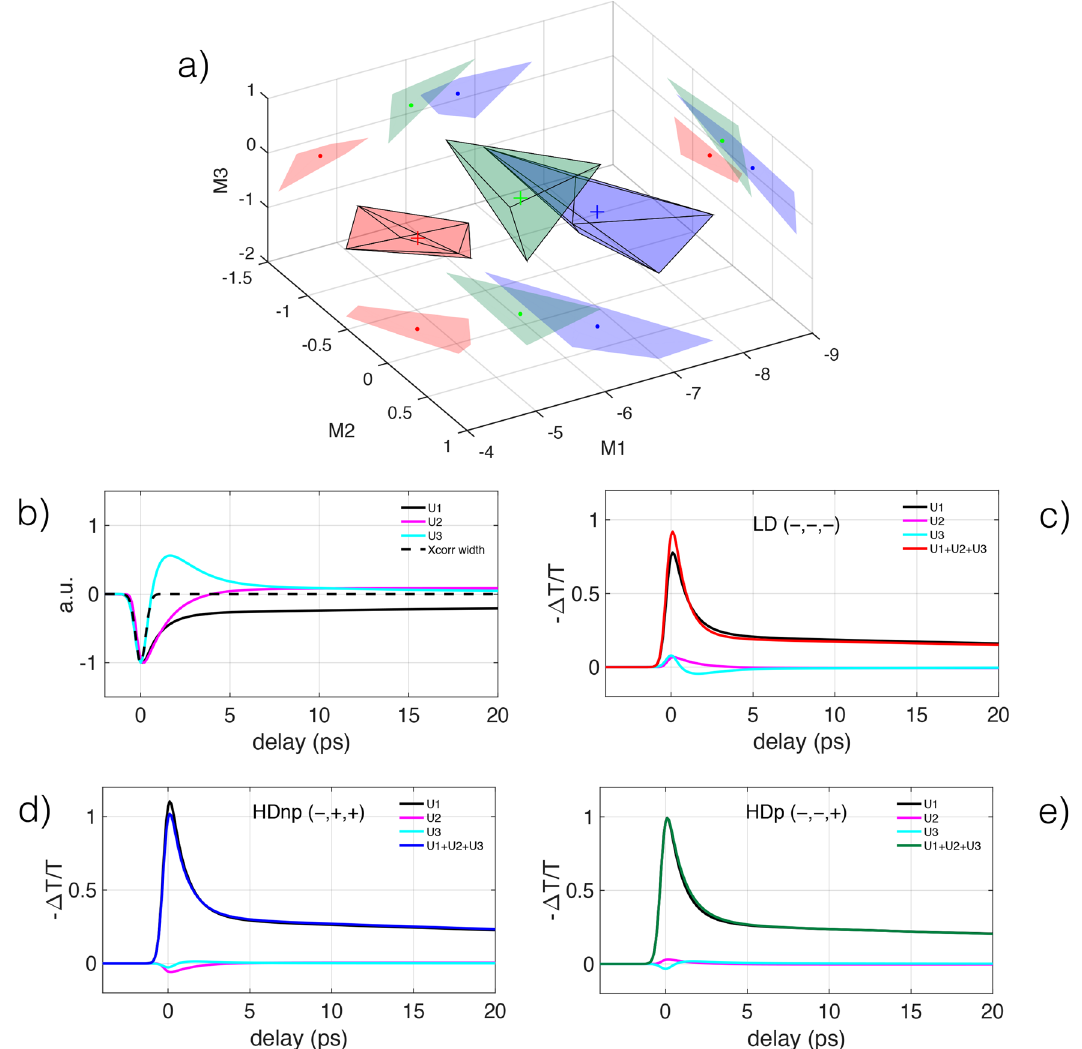
Figure 4. Results from Singular Value decomposition analysis on the data fit functions. In ( a ) are shown the convex hulls of each data group. The convex hulls are shown as the smallest (semitransparent) convex polyhedra that contain all the points of each group. The coordinates (M1, M2, M3) represent the projections of each spectrum onto the three eigenvectors with the highest eigenvalues. The color code is the same as in Fig. 2. In ( b ) the shapes of the first three eigenvectors ( U 1 , U 2 , U 3 ) are shown. The shape of the pump-probe cross correlation is shown as a dashed black line. In ( c ) is shown the reconstructed barycentric trace for the low-density case (red cross in a )), obtained by the sum of the first three weighted eigenvectors. The three weighted eigenvectors are shown for comparison with the reconstructed barycentric trace. ( d ) and ( e ), same as c) for the cases of high density without plasma treatment and high density with plasma treatment,